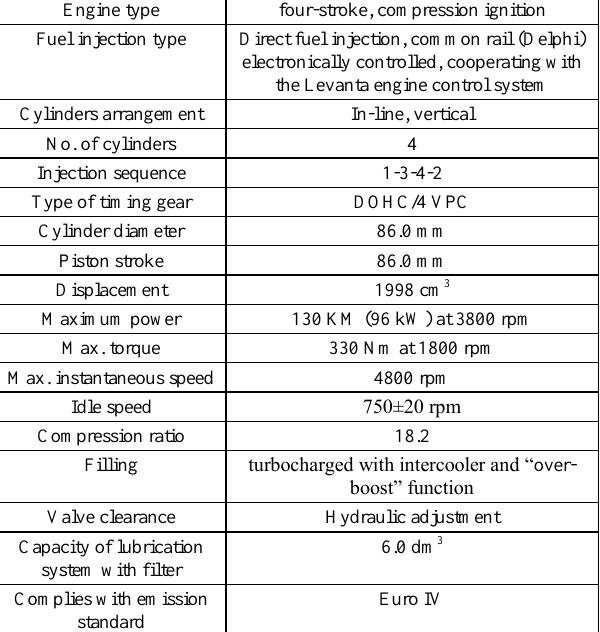
Table 1. Selected technical parameters of the FORD 2.0i 16V Duratorq TDCi engine